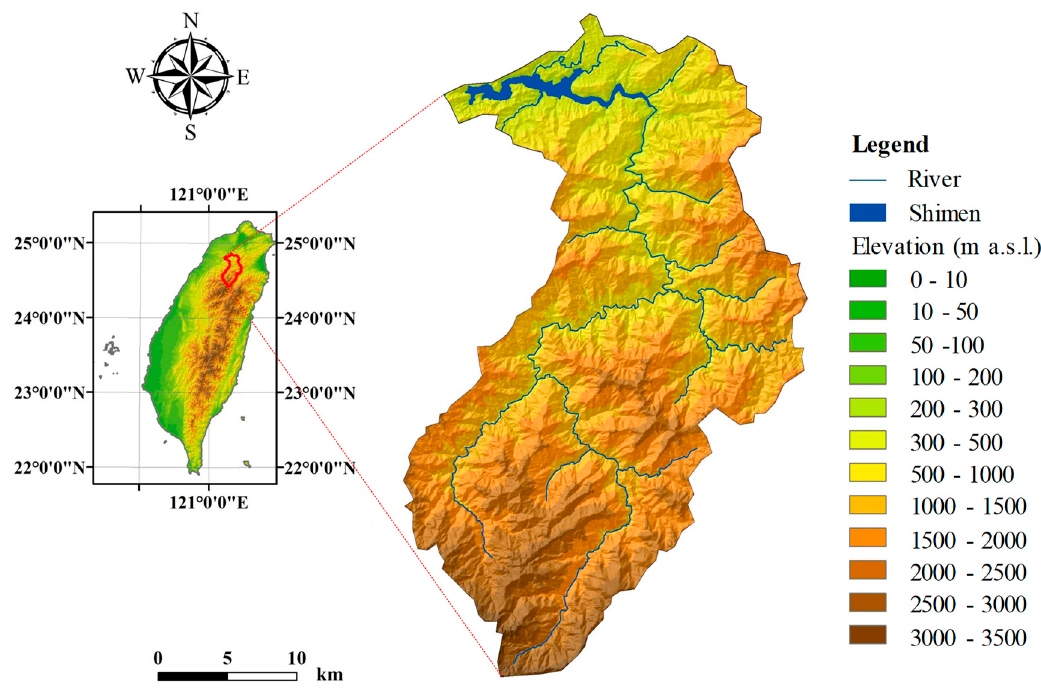
Figure 2. Location of Shimen Reservoir.